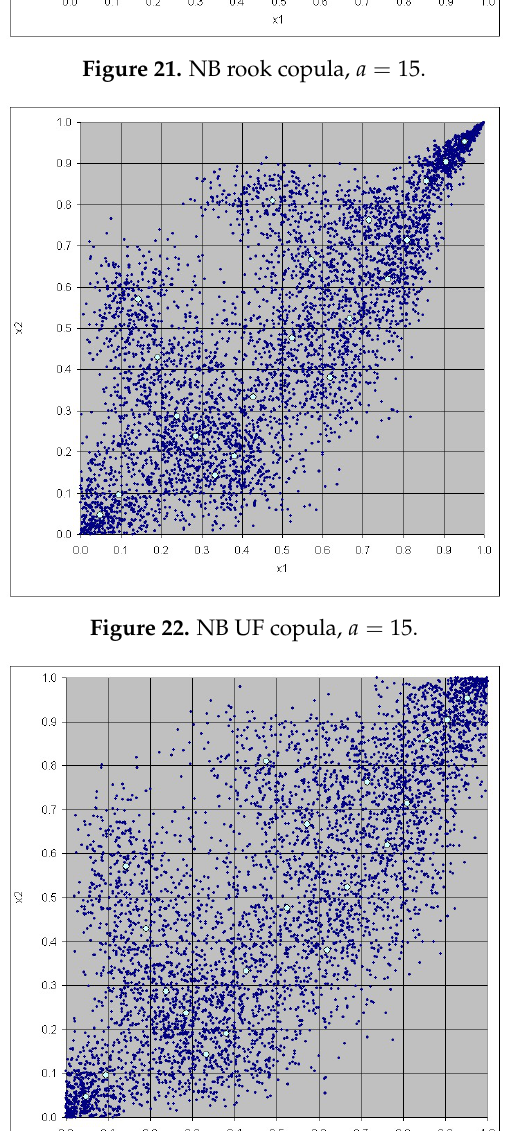
Figure 23. Bernstein